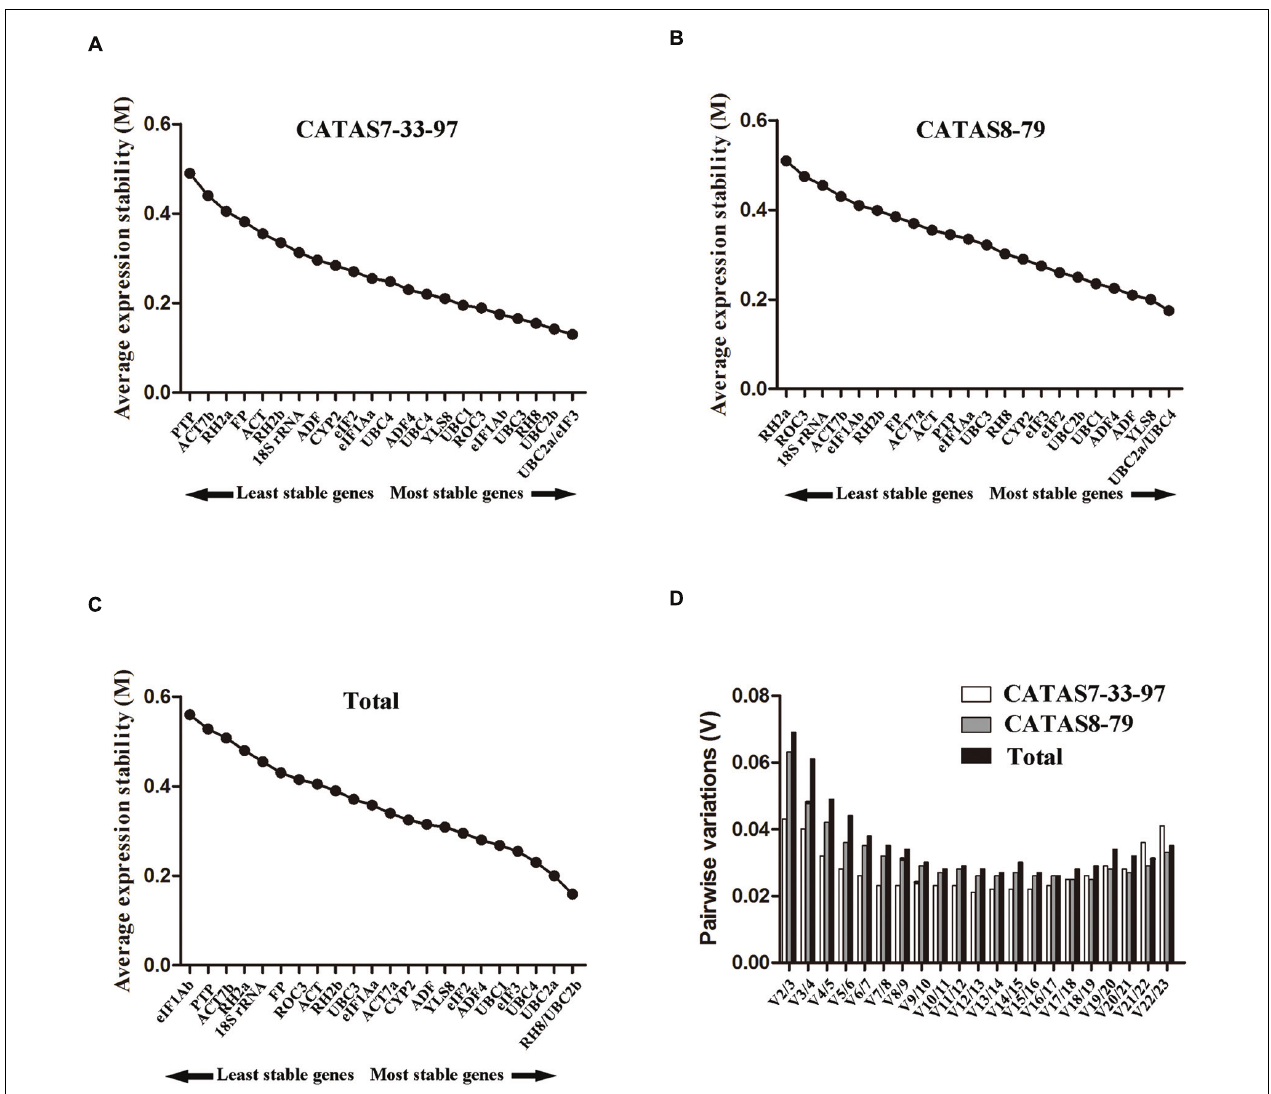
FIGURE 3 | Average gene expression stability (M) and pairwise variation (V) analyses of the candidate reference genes in different sample sets generated by the geNorm software. The ranking of the gene expression stability performed in CATAS7-33-97 (A) , CATAS8-79 (B) and total sample (C) . The most stable genes are on the right, and the least stable genes are on the left. (D) Pairwise variation calculated to determine the minimum number of reference genes for accurate normalization.